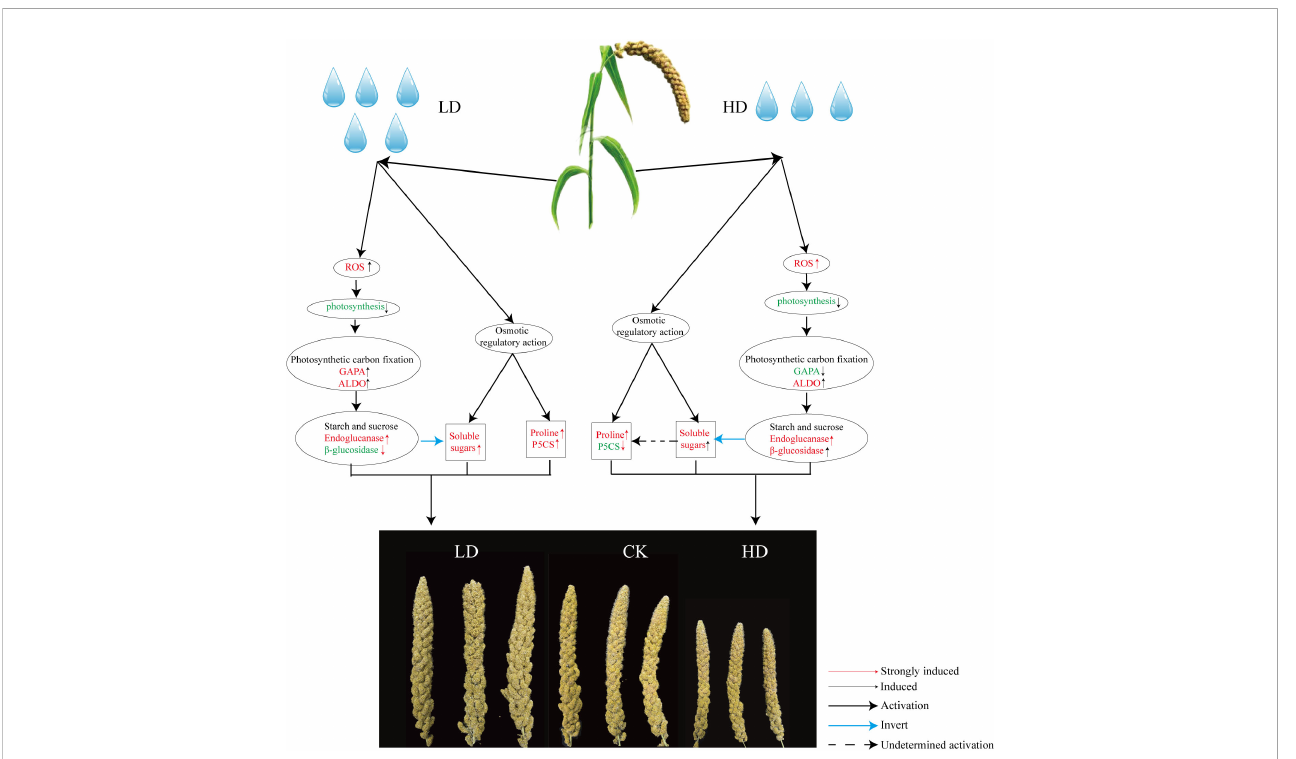
FIGURE 10 Regulation model of foxtail millet under drought stress at yield formation stage and the key pathway including phytohormones, antioxidants, phenylpropanoid synthesis pathways, osmotic regulatory pathways, and photosynthetic carbon fi xation pathways. Red font indicates increased and up- regulated change. Green font indicates decreased and down-regulated